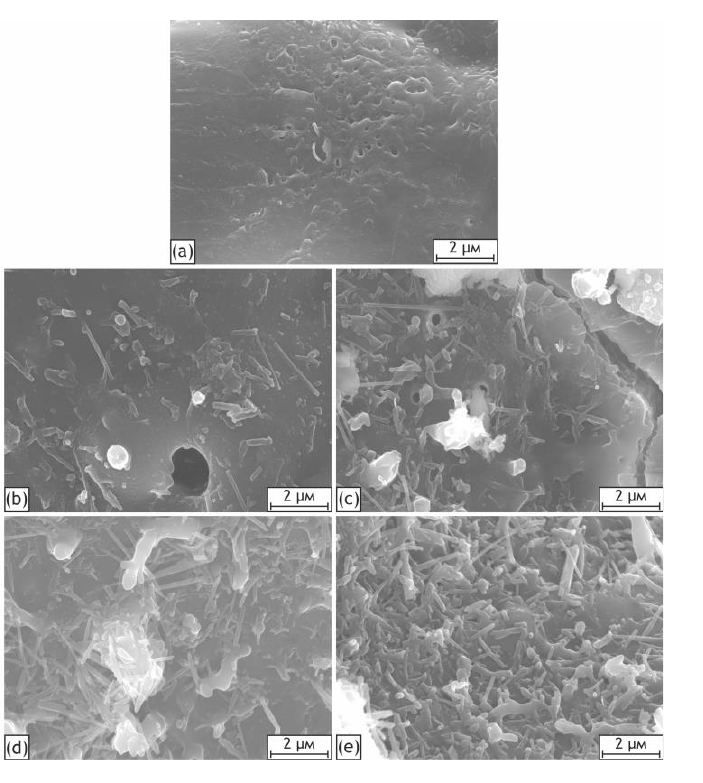
Figure 2. SEM images of coatings cross sections: H0 ( a ), H10 ( b ), H20 ( c ), H30 ( d ), H40 ( e ).